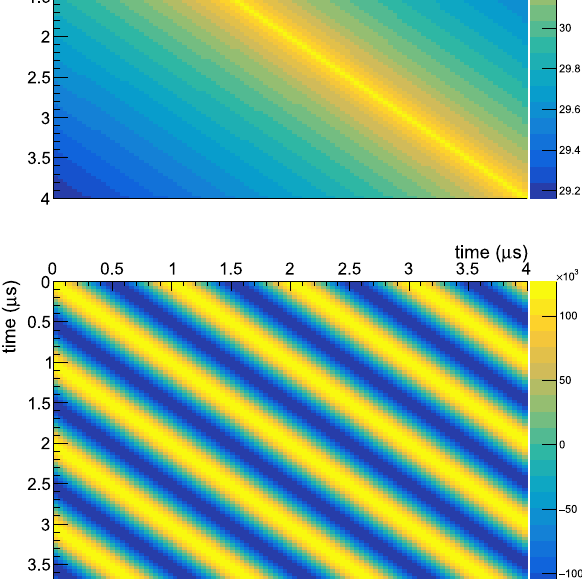
in Fig. 7 represents purely series noise, with absolutely pre- dominant positive values in a very narrow band around the principal diagonal. The mid-panel layout of Fig. 7 represents purely parallel noise, this time showing slowly and mono- tonically decreasing values towards the two opposite matrix corners. The bottom panel layout of Fig. 7 represents the case of a small amount of series noise superimposed to a sinusoidal disturbance at 5 MHz frequency. The typical peri- odic correlation pattern of sinusoidal disturbances usually appears from the matrix layout, as in this case, also